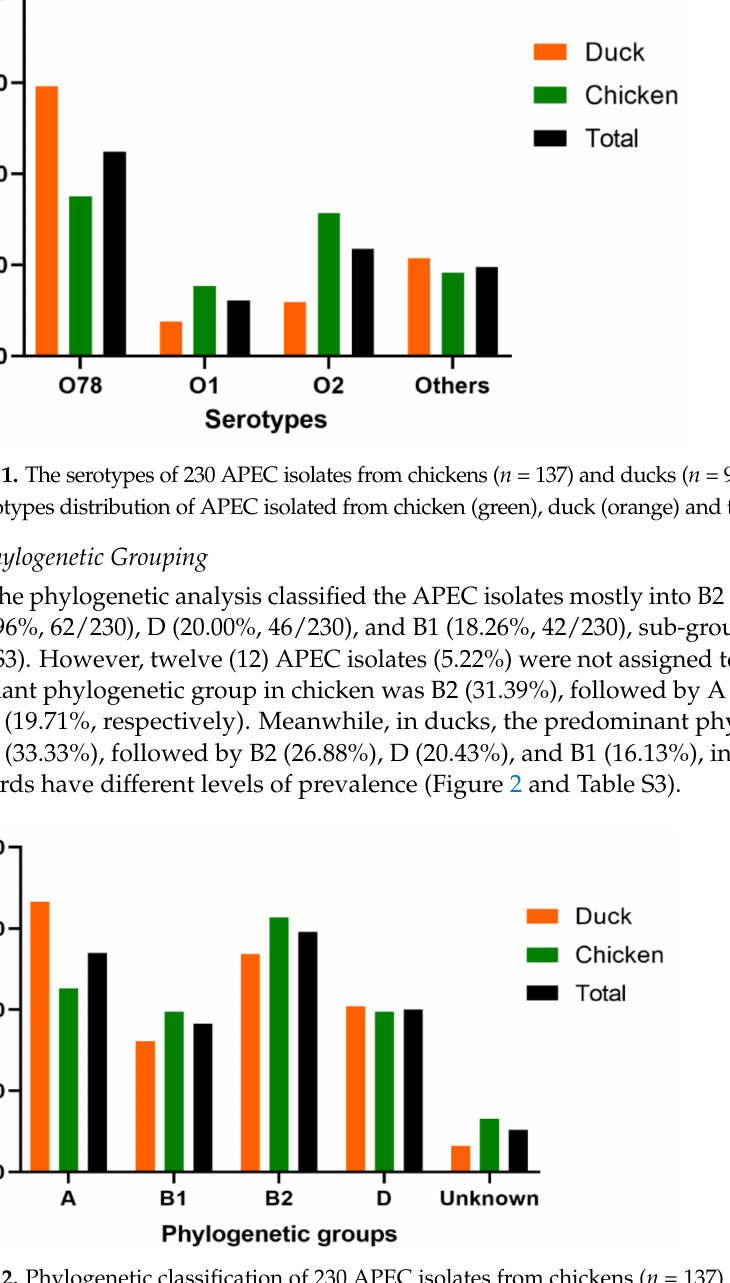
Figure 2. Phylogenetic classification of 230 APEC isolates from chickens ( n = 137) and ducks ( n = 93). Bar charts show the phylogenetic groups distribution of APEC isolated from chicken (green), duck (orange) and total